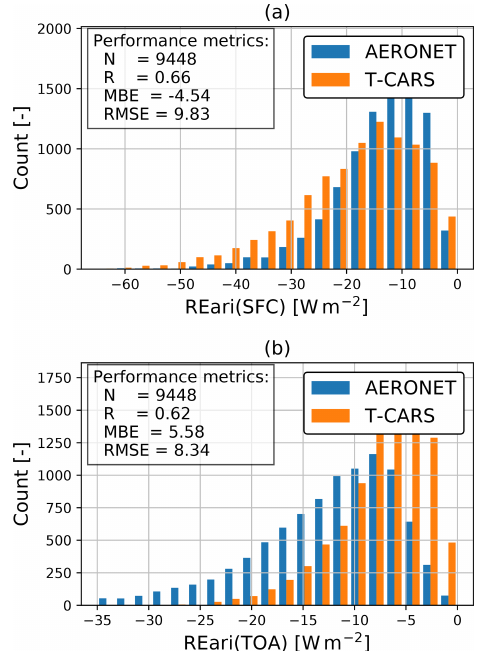
Figure C1. Comparison of AERONET and T–CARS REari daily average products at the surface (SFC) and top of the atmosphere (TOA) for the period from 2003 to 2019. The metrics are calculated using the definition of REari (global instead of net irradiance at the surface) from AERONET and the AERONET data as reference.